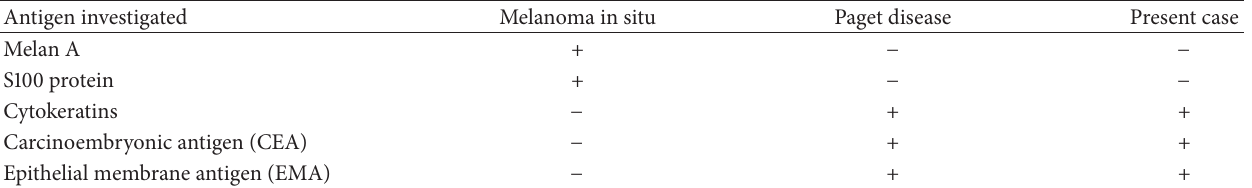
Table 1: Differentiation between the immunohistochemical profile commonly found in skin melanomas and that found in Paget disease in comparison to the present